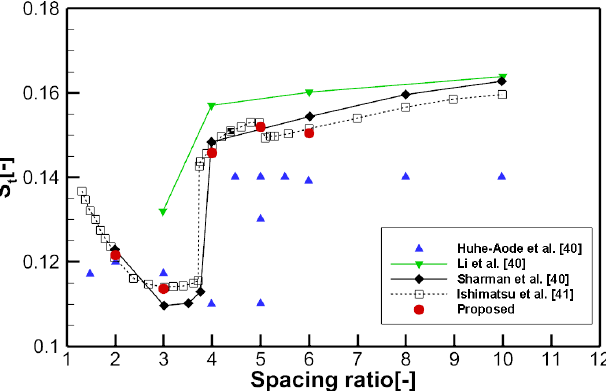
Figure 19. Comparison of Strouhal numbers for two circular cylinders in tandem arrangement ( Re = 100).